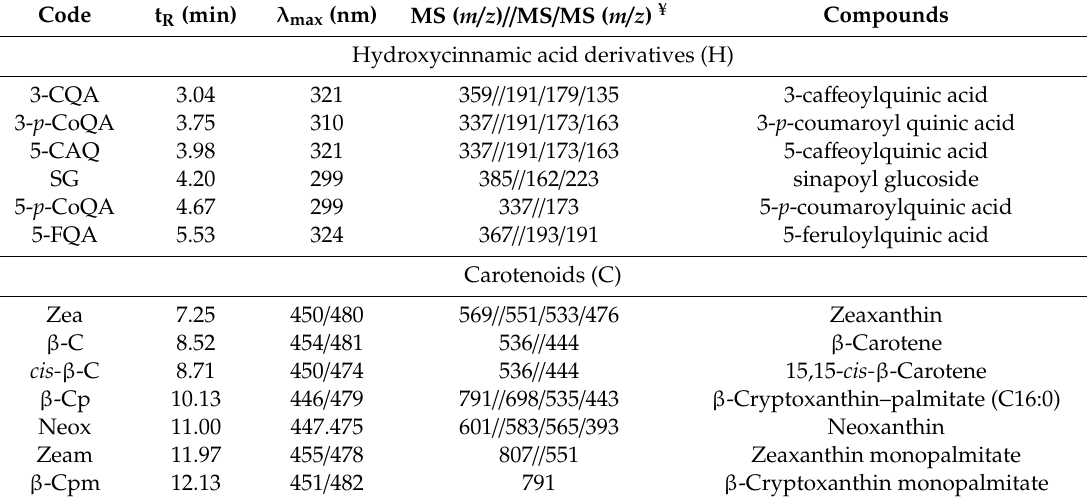
Table 2. Characteristic bioactive compounds of dried